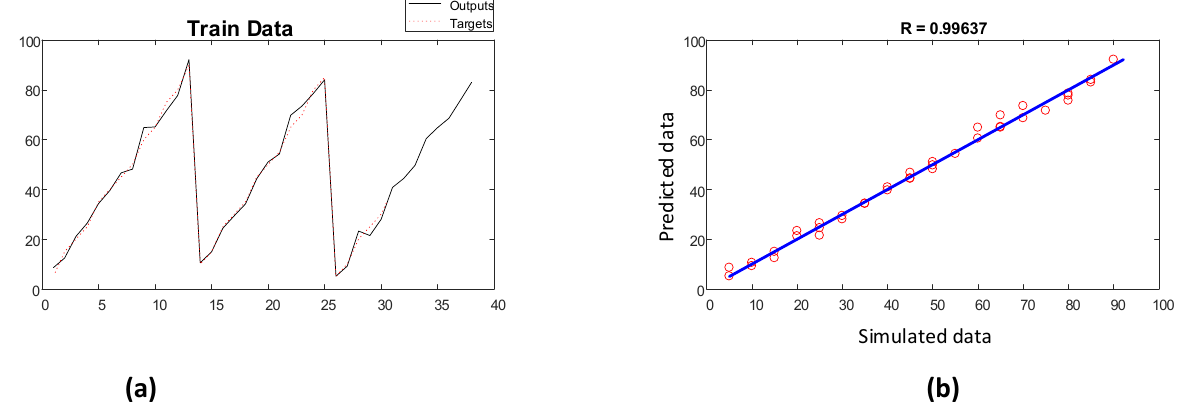
Figure 11. Performance of void fraction estimator network (training): ( a ) fitting diagram and ( b ) regression diagram.